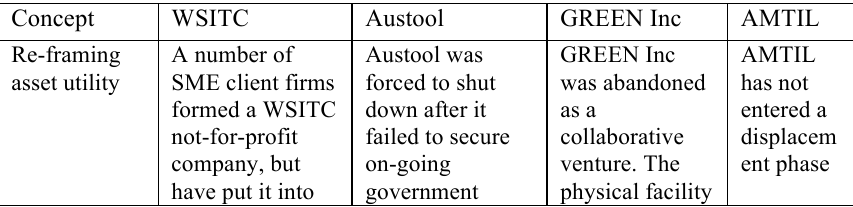
Table 8. Displacement phase